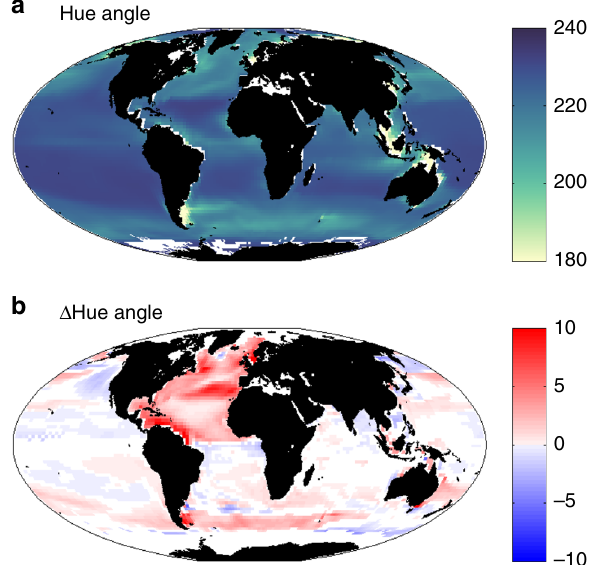
Fig. 5 Hue angle. a Mean for 1998 – 2015, b difference in model 2085 – 2100 mean and the current day (1998 – 2015). In b only areas with a statistically signi fi cant differences between the two periods ( p < 0.05) and which were ice free for most of the year (i.e. open ocean where R RS was calculated) in the current day are